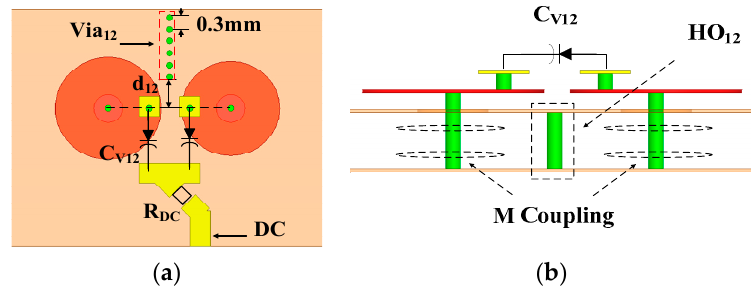
L 23 , and also can be tuned with C v23 . Figure 5. Coupling schematic for the proposed filter.